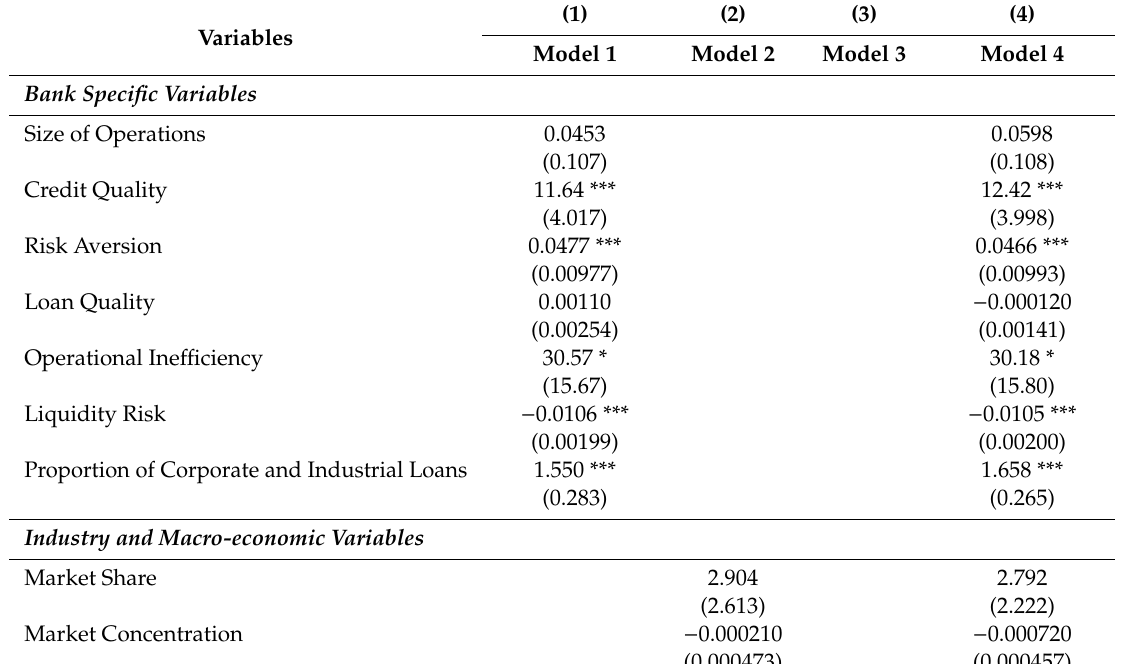
Table 4. Fixed e ff ects regression results: adjusted interest spread (AIS) as the dependent